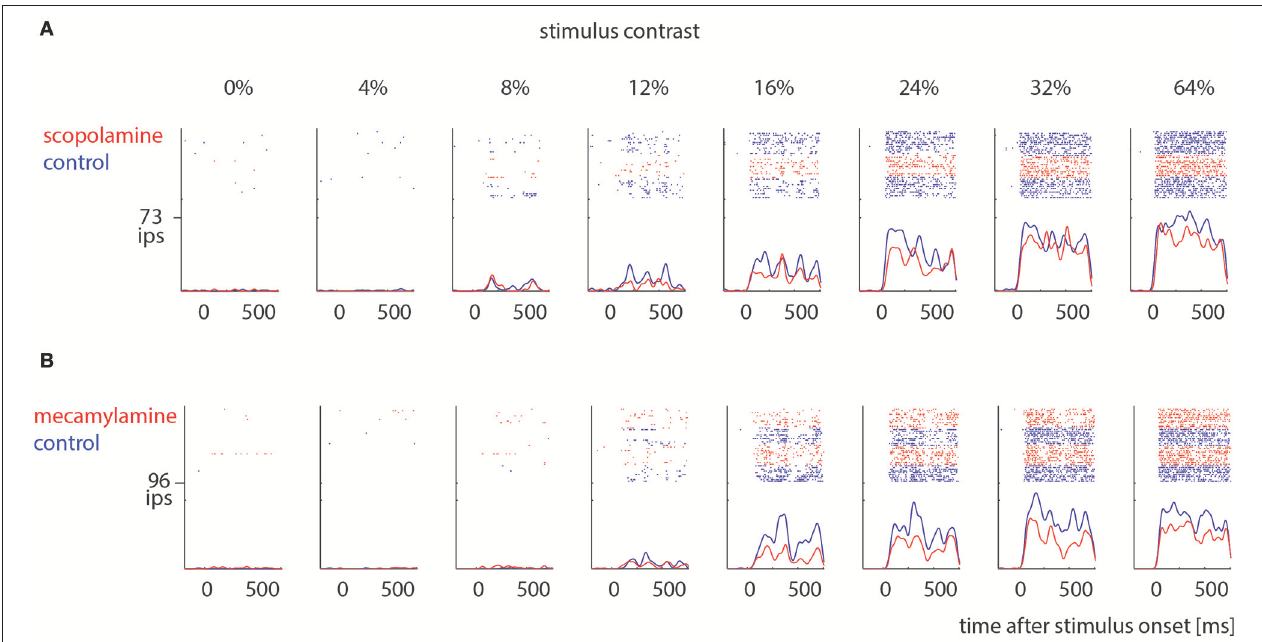
FIGURE 2 | Examples of drug effects on neuronal activity across different stimulus contrast. (A) Cell that was measured under control conditions (blue) and when scopolamine was locally applied (red). (B) Cell that was measured under control conditions (blue) and when mecamylamine was locally applied (red). Ips: impulses per